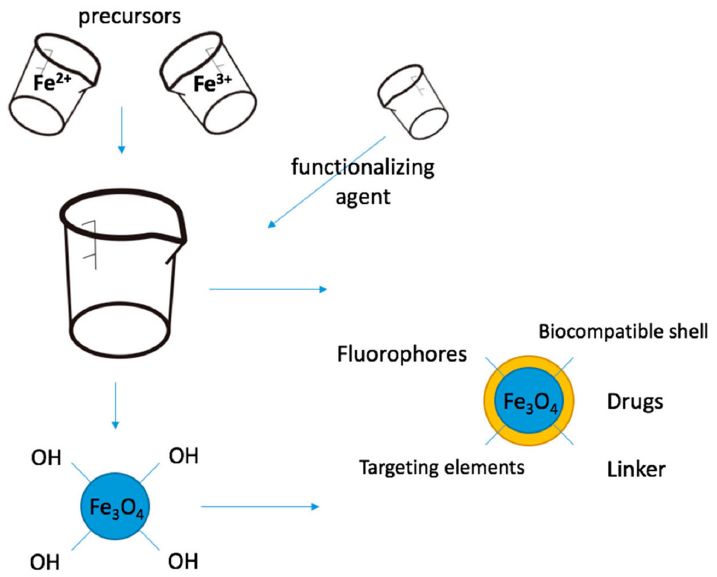
Figure 4. Schematic representation of the two main types of magnetite nanoparticle functionalization processes for medical applications: in situ and postsynthesis functionalization (reproduced without modification with permission from [69]).